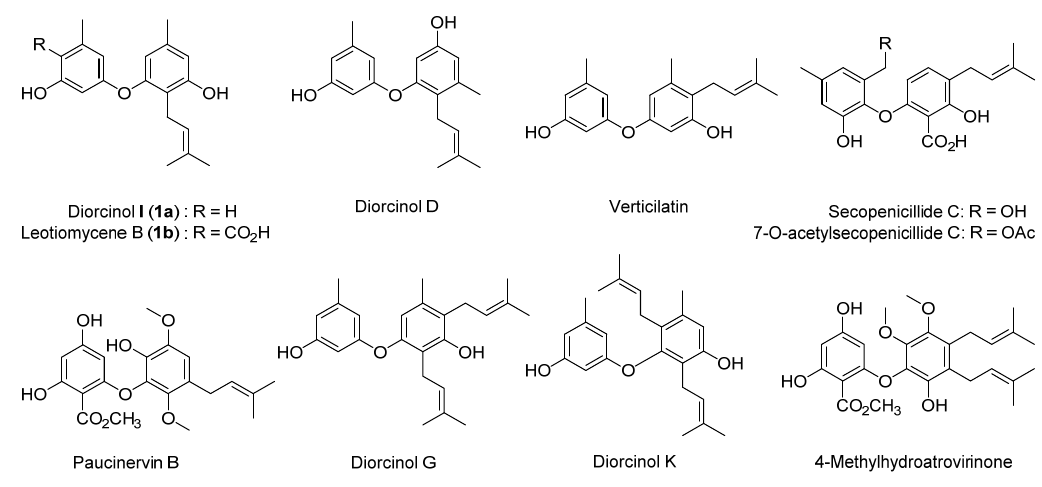
Figure 1. Bioactive prenylated diresorcinols.